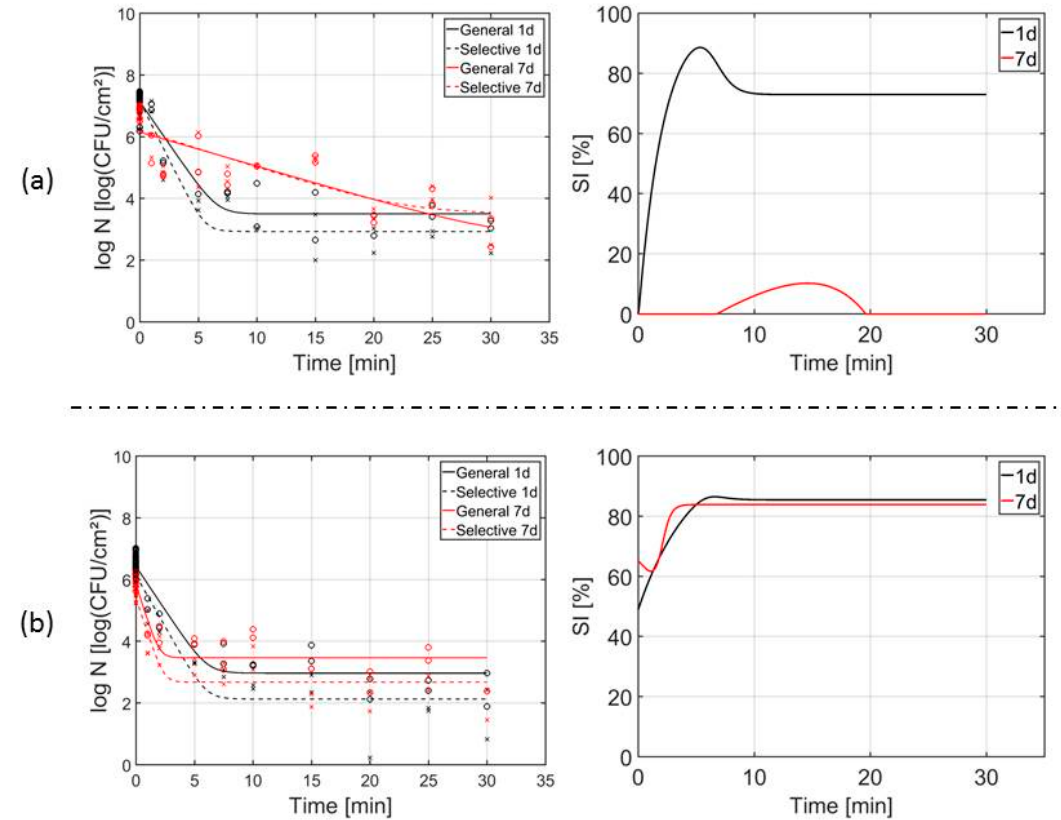
Figure 5. Cell density (log(CFU/cm 2 )) as function of the treatment time following CAP treatment of the one and seven day(s) old biofilms at optimal CAP conditions for biofilm inactivation. Experimental data (symbols) and global fit (line) of the Geeraerd et al. [27] model: total viable population on general medium (o, solid line) and uninjured viable population on selective medium (x, dashed line) (left). Percentage (%) of sub-lethally injured cells as function of the treatment time for both investigated biofilm ages (i.e., one and seven day(s)) (right). ( a ) Results obtained following CAP treatment of the L. monocytogenes biofilms; ( b ) Results obtained following CAP treatment of the S. Typhimurium biofilms. Table 1. Estimated model parameters Geeraerd et al. [27] model for the inactivation curves of one and seven day(s) old L. monocytogenes and S. Typhimurium biofims. Results for the one ‐ day old biofilms have been presented before in the research of Govaert et al. [17].